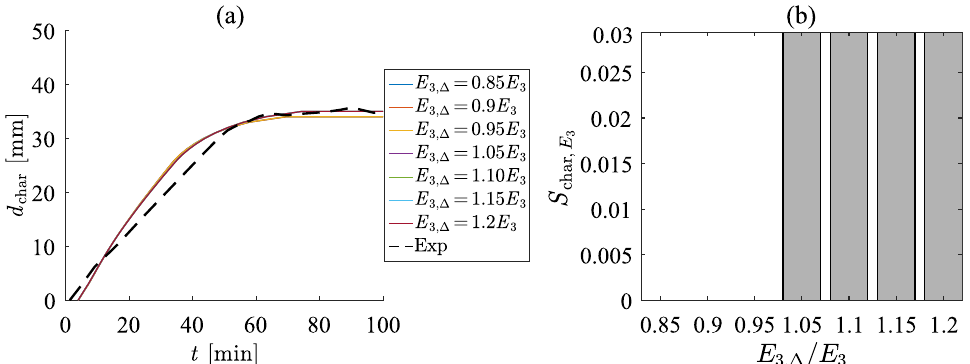
Fig. 6 a The development of charring depth for varied parameter E 3, (cid:31) . b Sensitivity index S char, E charring depth